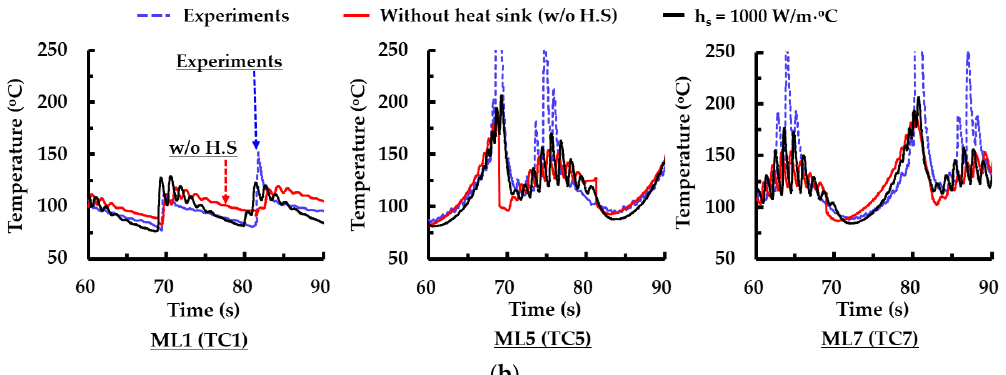
Figure 7. Comparison of temperature histories of experiments and those of FEAs for different heat sink conditions (type 2 path of ADDSs): ( a ) temperature histories for all measured locations (from the first layer deposition to the 8th layer deposition); ( b ) detailed temperature histories for selected deposition times and MLs.